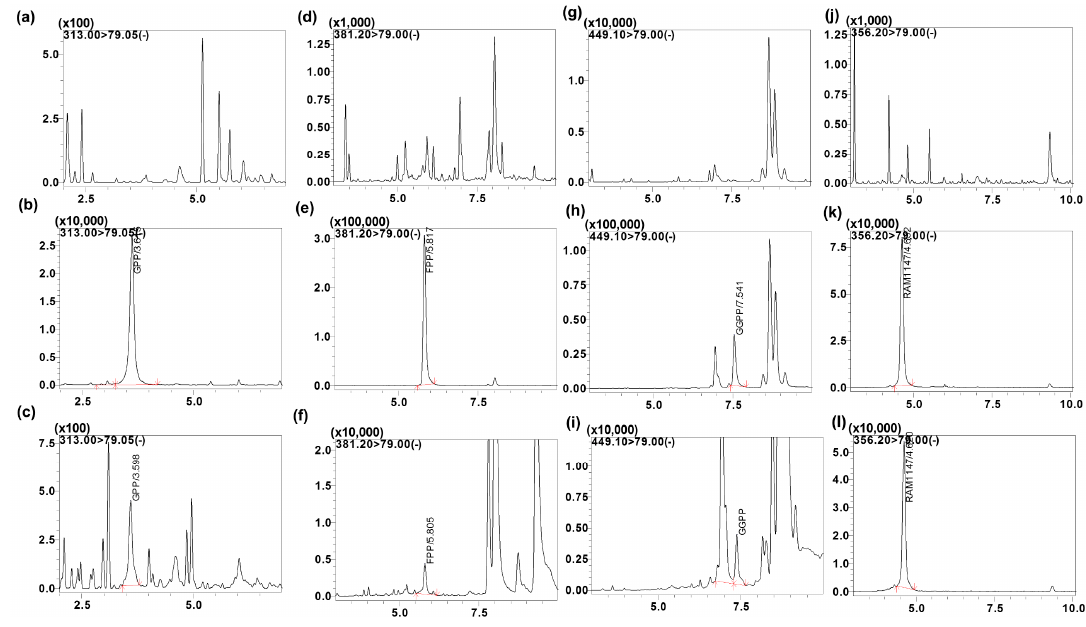
7 of 13 Figure 2. MS/MS product ion spectra of ( a ) GPP, ( b ) FPP, ( c ) GGPP and ( d ) RAM1147 (internal Standard). Chromatographic conditions were optimized to separate all IsoPs of interest from interference with a desirable peak shape and signal intensity using an ACCQ ‐ TAG Ultra C18, 100 mm × 2.1 mm I.D., 1.7 μ m, column (Waters). Different solvent systems such as MeCN and MeOH with various buffers including ammonium carbonate and ammonium bicarbonate with different pH ranges, composition and different flow rates were evaluated. The suitability and robustness of the method were evaluated using different varieties of reverse phase HPLC columns ranging from 50 mm to 150 mm in length (data not shown). The less hydrophobic IsoPs including MVA and IPP eluted early and independently of the mobile phase pH. NH 4 OH (0.1%) was used as an aqueous and organic mobile phase modifier as a basic pH mobile phase resulted in better peak shape and a longer retention of the more hydrophobic IsoPs including GPP, FPP and GGPP. Under our final LC ‐ MS/MS conditions, all IsoPs of interest were resolved from each other as well co ‐ eluting isobaric interferences for target analytes in less than 10 min. IsoPs are endogenous compounds and are isobaric with very similar physio ‐ chemical properties. Endogenous compounds not only share the same mass, but also may have the same fragmentation ion (79 is common ion representing the phosphate group), resulting in the same MRM transitions. In addition, interfering peaks could arise from other unknown endogenous matrix components.